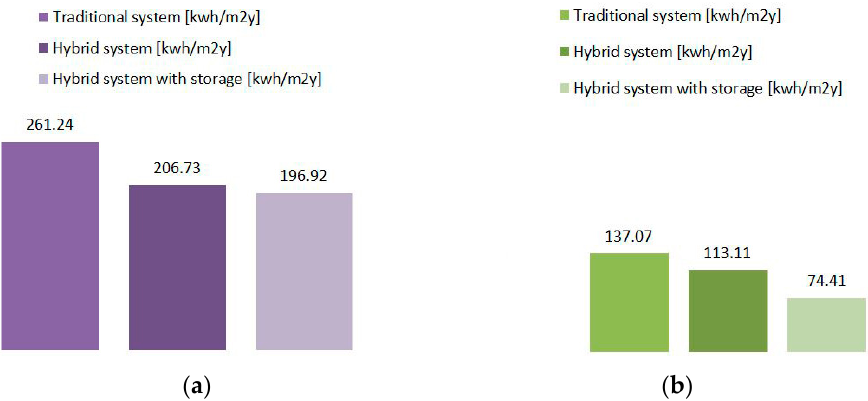
Figure 15. Sensitivity analysis on Performance indicators with changes in building Electrical loads, when a batteries bank is connected.